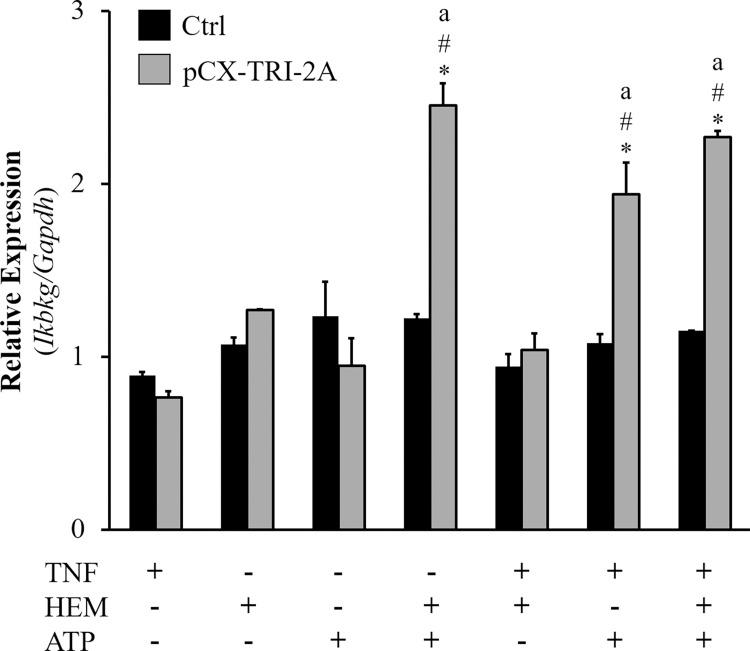
Changes in Ikgkb (Nemo) mRNA expression in control (Ctrl) and pCX-TRI-2A-transfected cells.Cells were incubated with 50 ng/ml TNF-α for 16h, alone or in combination with 20 μM hemin and/or 200 μM ATP. Murine Ikgkb mRNA was quantified by real-time PCR. The data (mean±SD of three independent experiments), normalized for Gapdh gene, are expressed as fold change respect to the untreated cells. [*] indicates a significant difference between pCX-TRI-2A-transfected cells and Ctrl cells within the same treatment (t Student, p<0.05); [#] indicates a significant difference as compared to untreated cells within the same cell type (ANOVA, p<0.05) [a] indicates a significant difference as compared to TNF-α treatment alone within the same cell type (ANOVA, p<0.05).